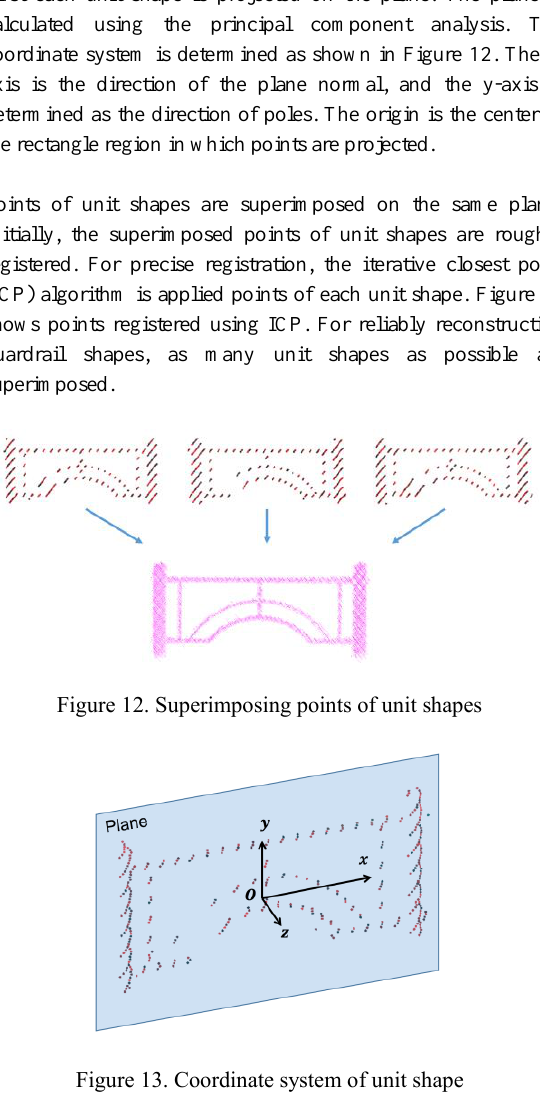
Figure 13. Coordinate system of unit